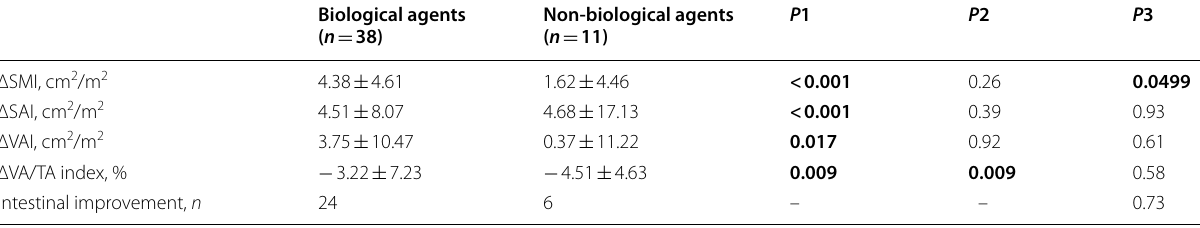
p values below 0.05 are marked in